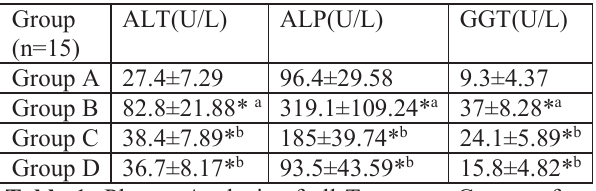
Table-1: Plasma Analysis of all Treatment Groups after six weeks * a =p< 0.001 when compared with Group A (Control) * b = p< 0.001 when compared with Group B